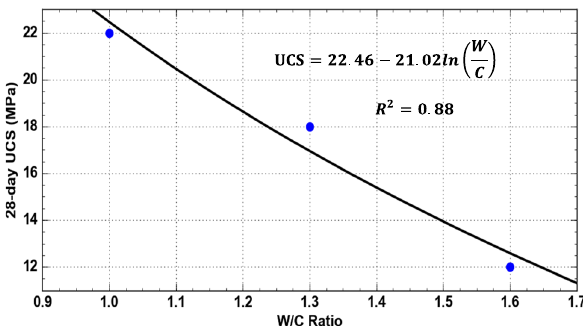
Figure 3: UCS – W/C ratio for SF